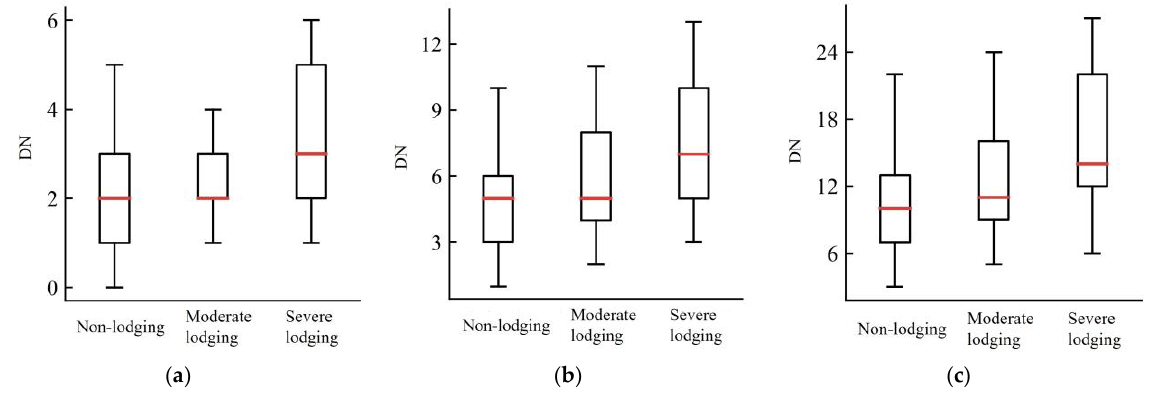
Figure 6. Comparison of gray level with 8 ( a ), 16 ( b ), and 32 ( c ) levels in GF-1 PMS images.